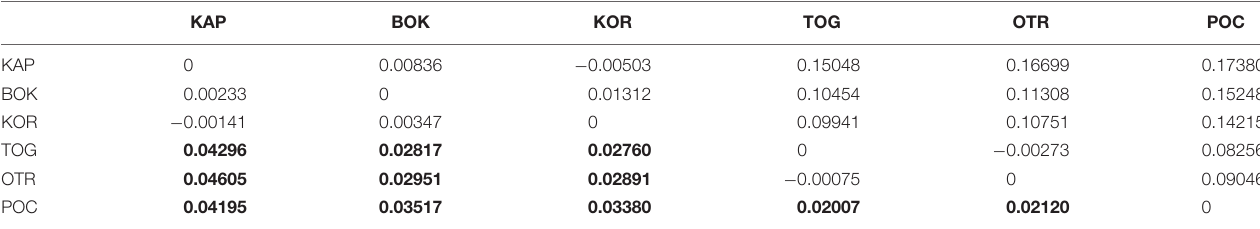
TABLE 3 | Genetic distances shown as F ST (below the diagonal) and standardized F ST values (above the diagonal). KAP BOK KOR TOG